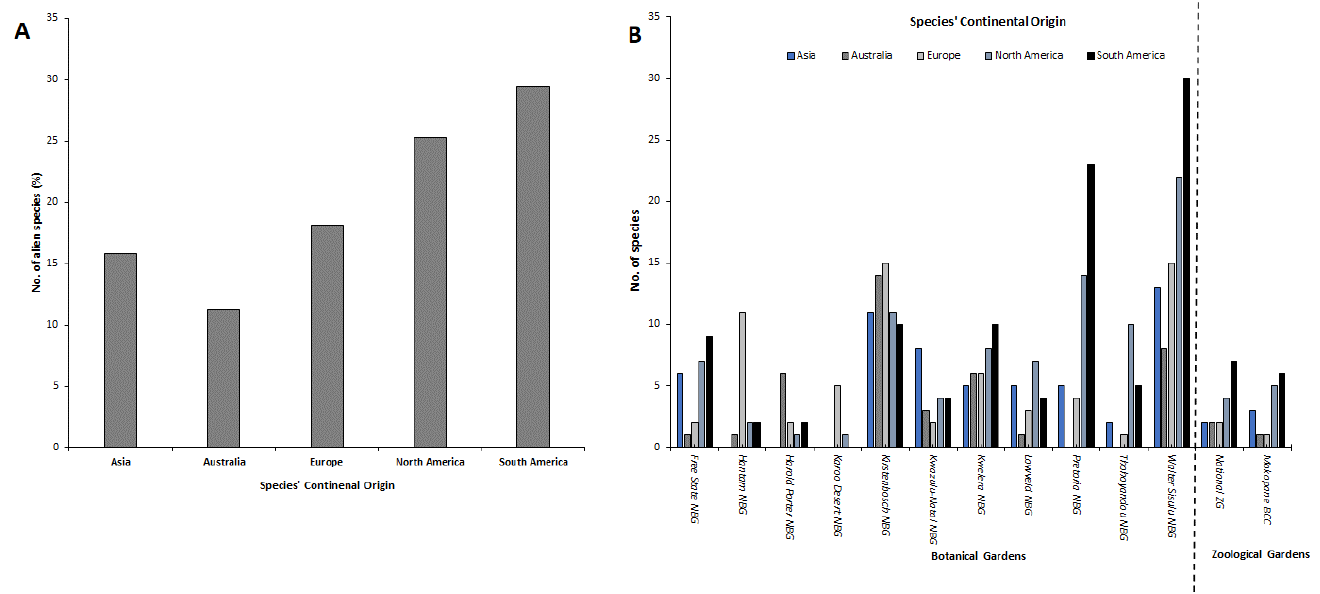
Figure 3. Number of records of different alien species from different continental space (%; n = 380; ( A )) and their occurrence in different SANBI gardens ( B ).